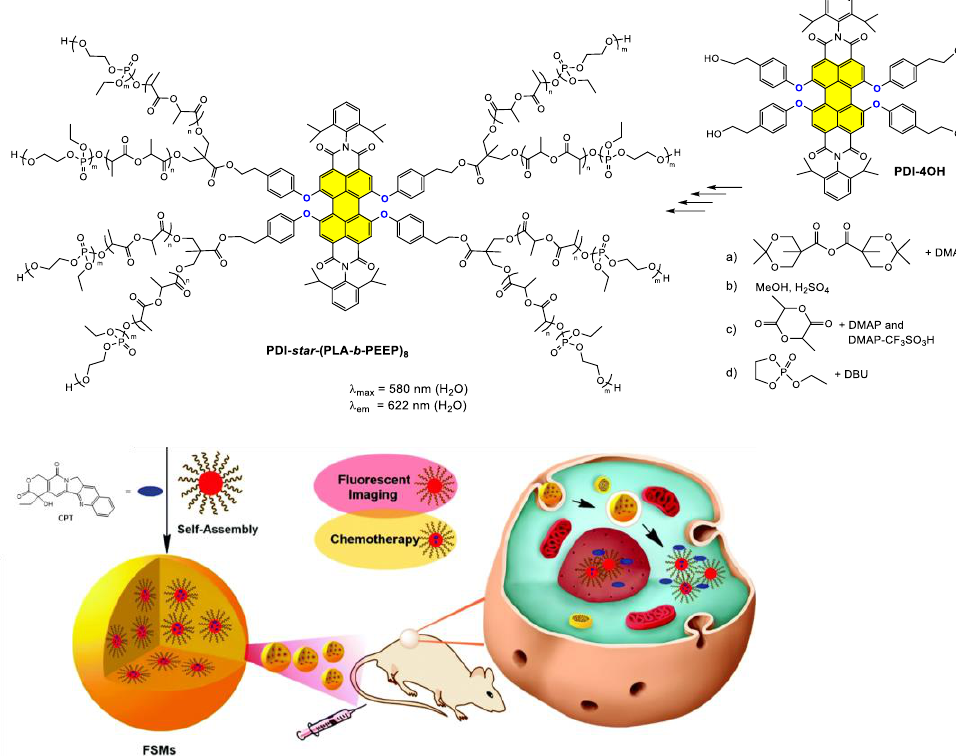
Figure 15. Synthesis of PDI-star-(PLA-b-PEEP) 8 ; formation of nanomicelles and fluorescence-imaging-guided intracellular drug release. Scheme adapted from reference [121]. Copyright 2016 Royal Society of Chemistry.